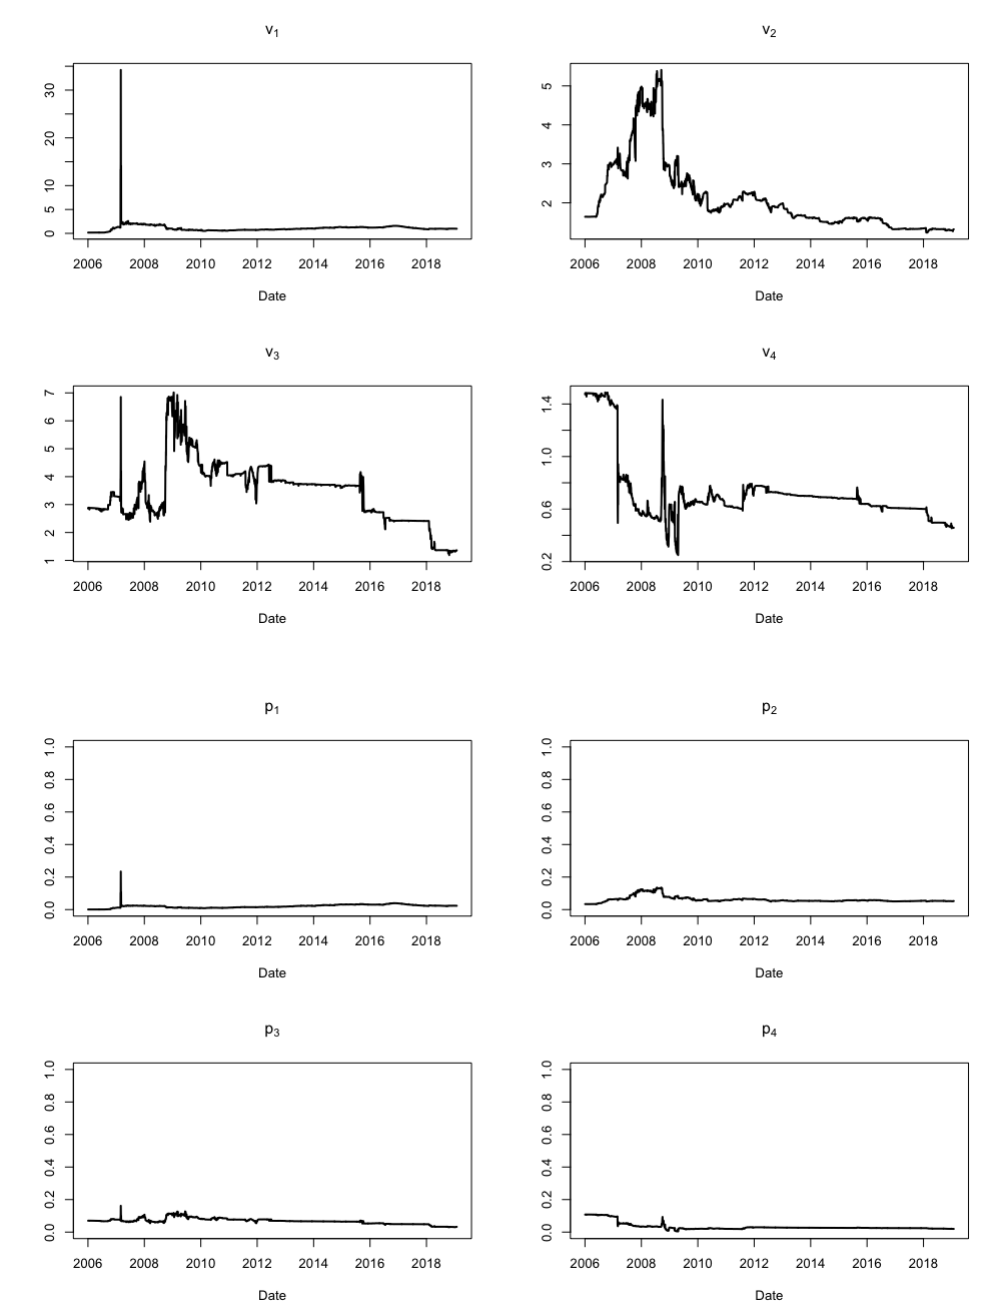
Figure 14. Expanding window: dwell-time parameters for the homogeneous four-state normal HSMM on S and P 500 daily log